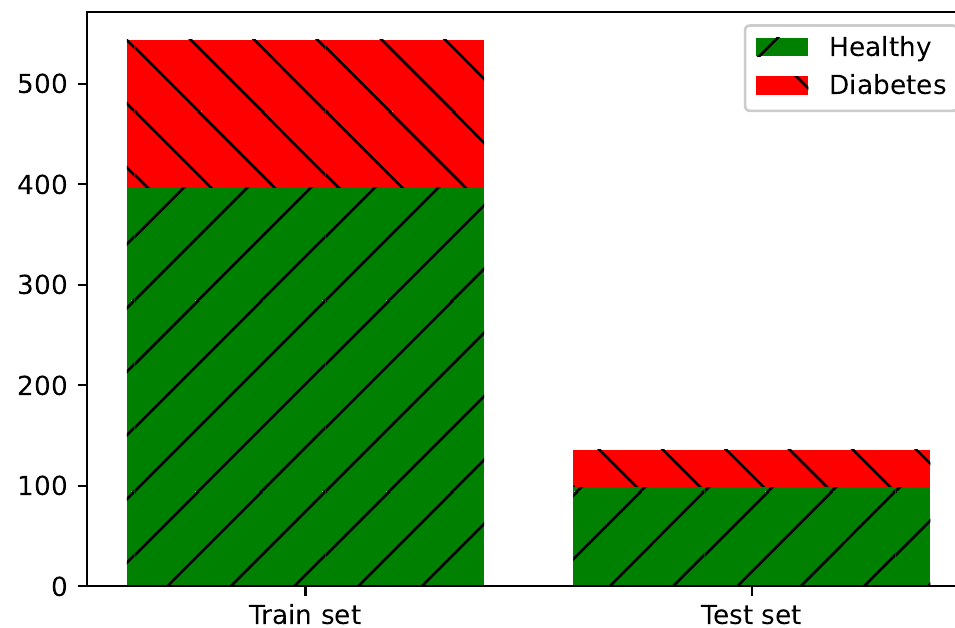
Figure 6. Dataset abundance and